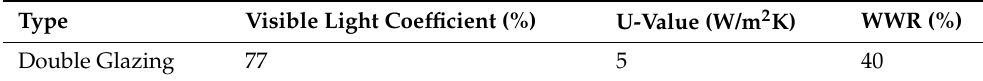
Window dimensions: for envelope optimization, the ratio of window to wall area is assumed to be 40%. The floor of the North and South windows is 80 cm from the inside floor and the size of the window above the finished ceiling is 26 cm. Daylight Sensors: the sensors predicted for this room are located 0.5 m away from each other at the height of 80 cm (Figure